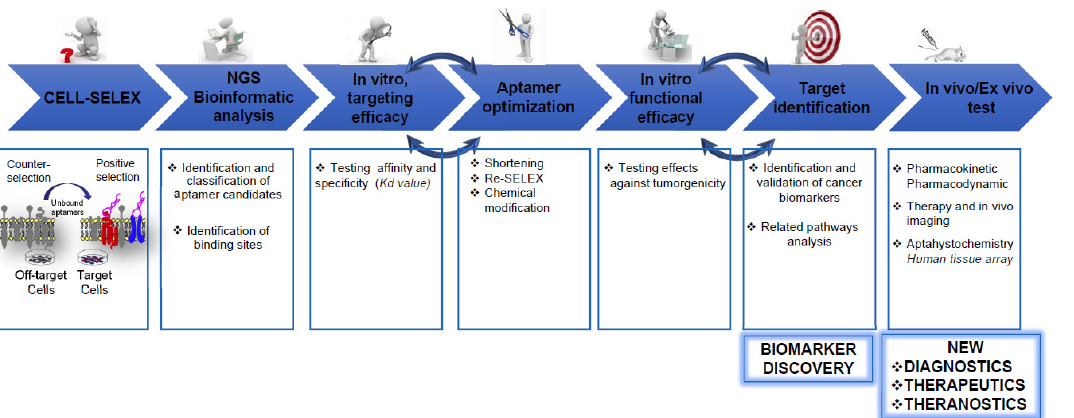
Figure 2. Aptamer discovery and development process. The image shows the sequential steps from the generation of aptamers by SELEX to their preclinical development as cancer-targeted therapeutics, imaging agents for diagnostics and theranostic molecules. Briefly, cancer cell-specific aptamers are generated by cell-SELEX against a specific cell type, without the prior knowledge of the molecular target. High affinity ligands are identified by classical cloning and/or high-throughput sequencing and bioinformatic analysis. The best aptamer candidates are tested in vitro for their affinity and specificity, optimized to increase their binding efficacy and tested in vitro/in vivo as cancer-targeted agents. The best binding aptamers are used as bait to identify their cell-surface targets, thus leading to discovery of novel biomarkers.